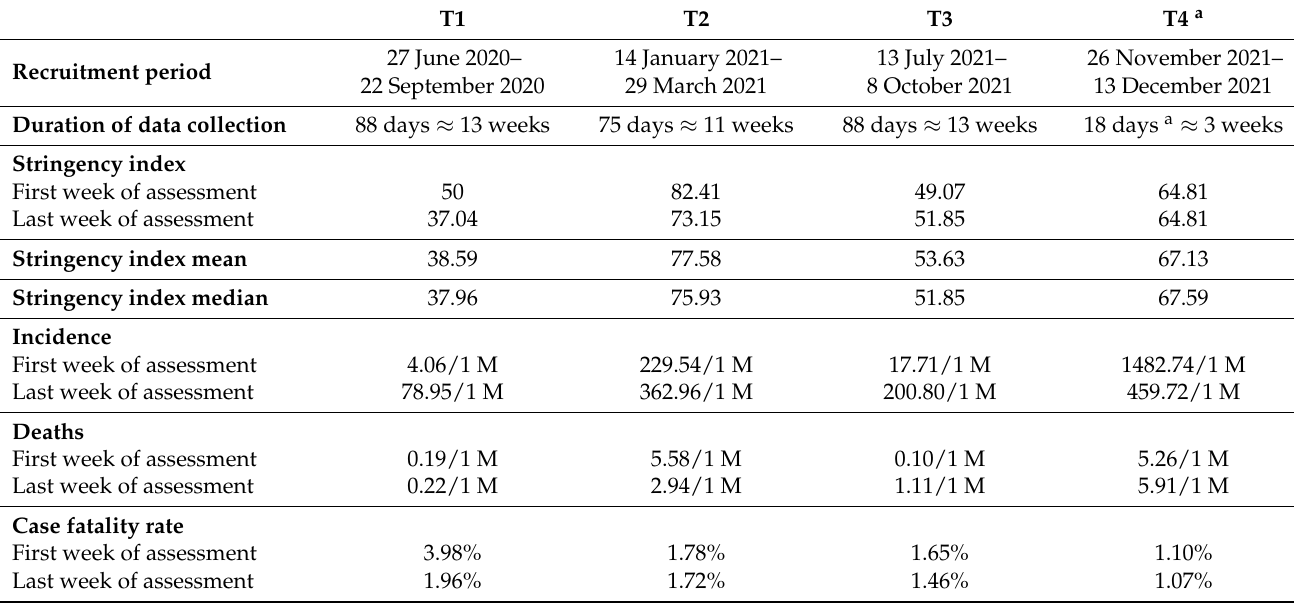
Table 1. COVID-19 situation at four timepoints of data collection. T1 T2 T3 T4